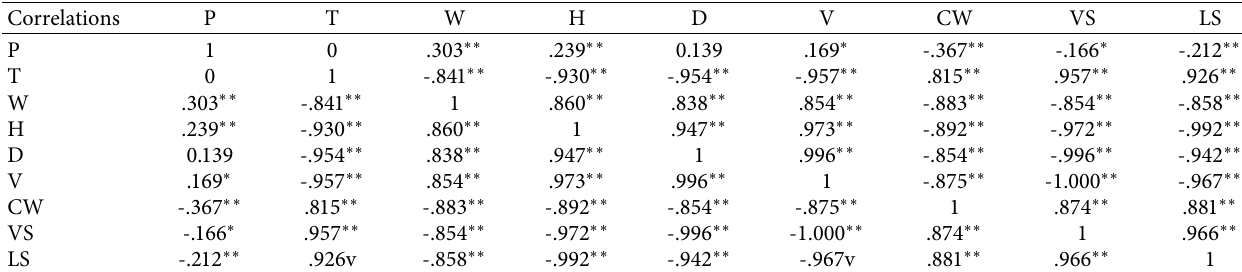
Table 2: Pearson’s correlation matrix of the input and output